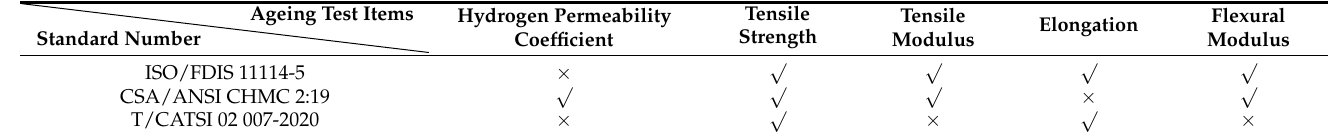
Table 9. Comparison of evaluating parameters among the three existing standards.